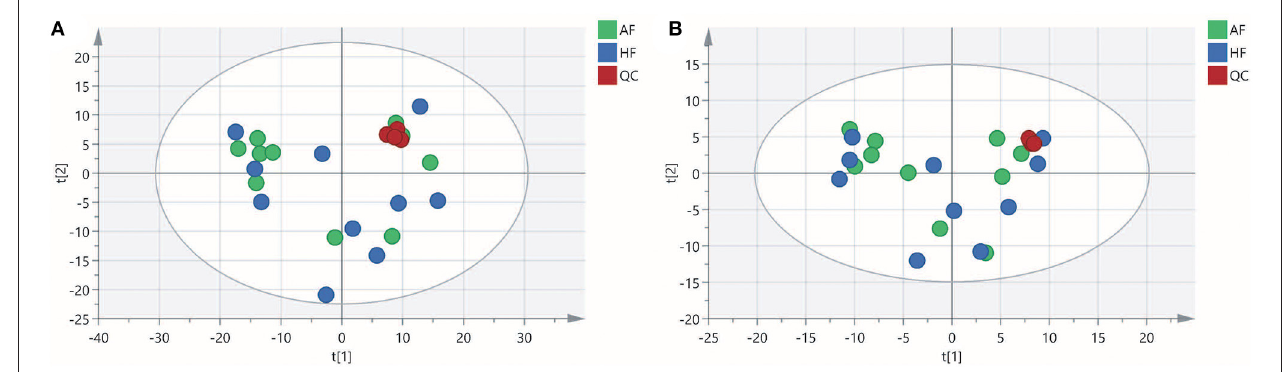
FIGURE 3 | Principal component analysis (PCA) score plot of the healthy follicle (HF) and atretic follicle (AF) groups. (A) PCA score plot for the two groups analyzed in the positive ion mode. (B) PCA score plot for the two groups analyzed in the negative ion mode. t[1] was the first principal component; t[2] was the second principal component.